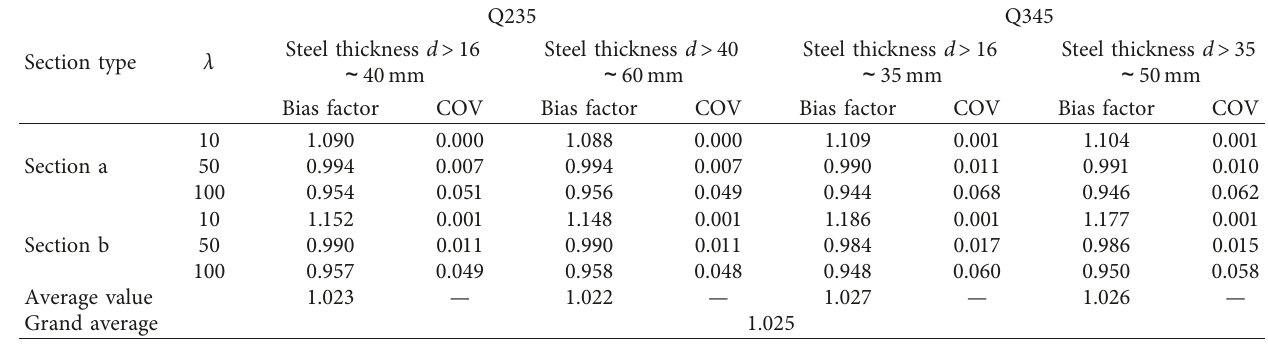
Table 3: Bias factor and COV of ϕ/ϕ